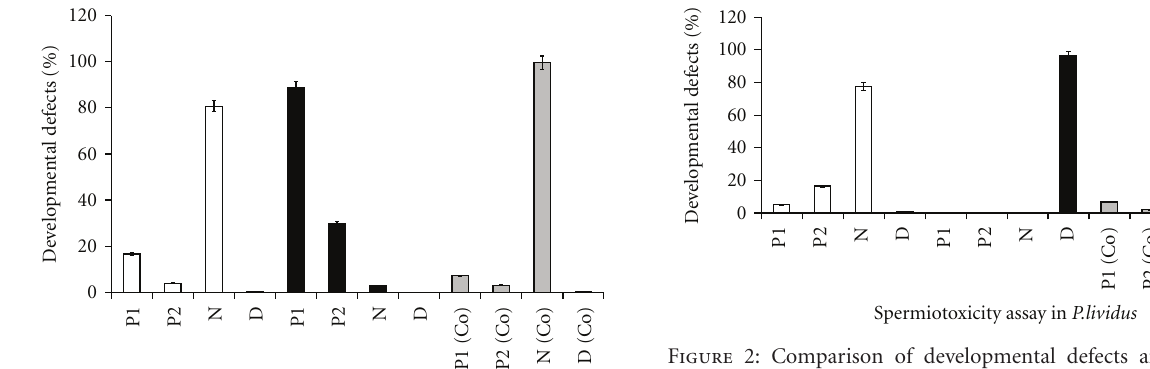
Figure 2: Comparison of developmental defects and mortality in P. lividus embryos following exposure to sperms. The gray bar represents the untreated negative control (C 0 ). Unpolluted and polluted amniotic liquid-induced developmental defects are represented, respectively, by white and black bars. P1, per cent larval malformations; P2, per cent developmental arrest at blas- tula/gastrula stage; D, per cent embryonic mortality, N, normal larvae. Results are expressed as means ± SE from six separate